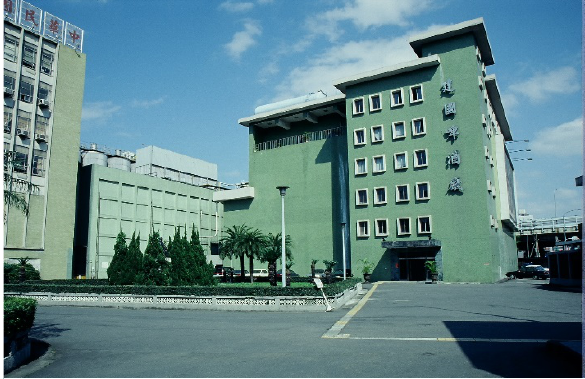
Figure 9: Taipei Jianguo Brewery was the first beer factory in Taiwan history, as known as a famous industrial